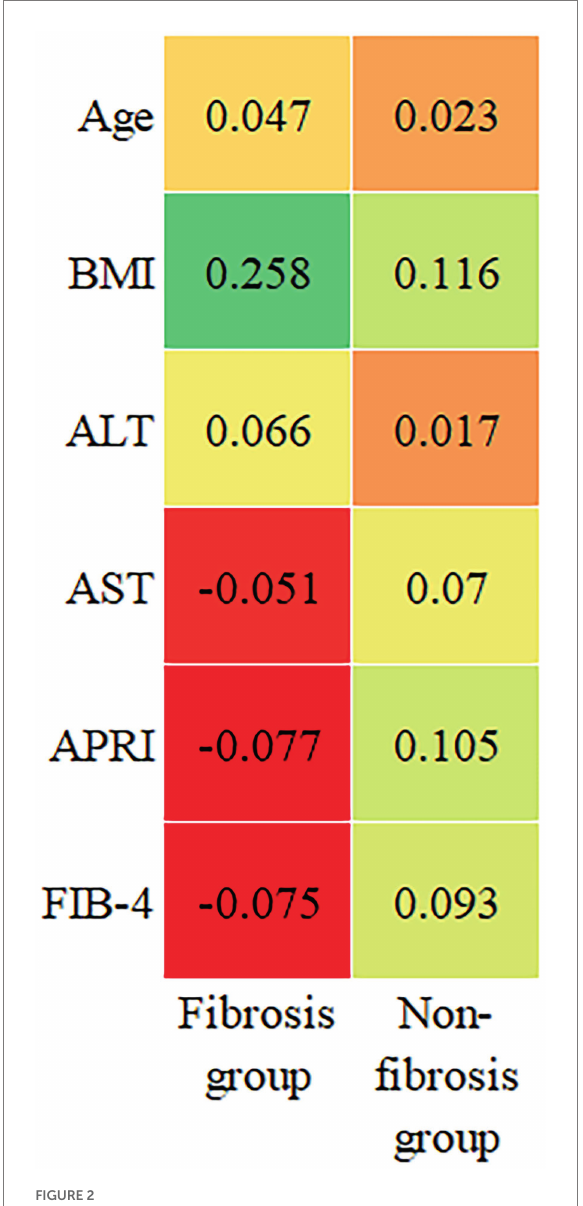
FIGURE 2 Associations of demographic and clinical characteristics with FCRL5 mRNA expression levels. FCRL5, Fc receptor-like